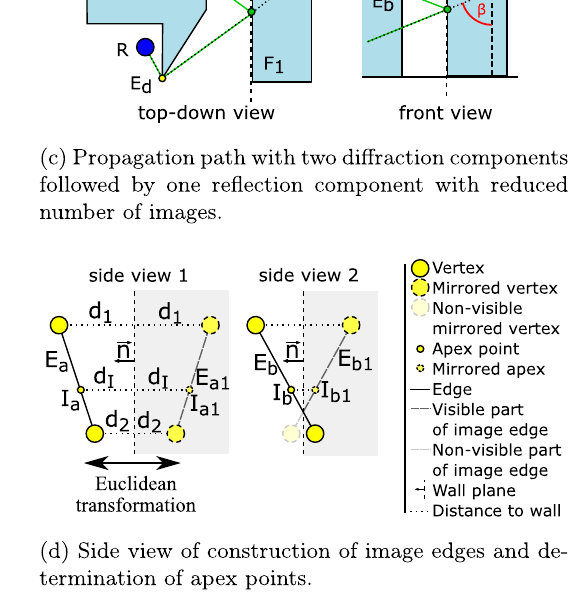
Figure 4. Determination of higher order propagation paths. In (a) the handling of multiple mirror operations of diffractions is depicted, in (b) higher order diffractions are applied and in (c) a reduced number of mirroring operations compared to (b) are applied due to the preserving of angles in Euclidean transforms. (d) depicts the determination of apex points and visibility aspects of image edges in three dimensional space. Analogous to the image source method, the mirrored apex point must lie behind the re fl ection